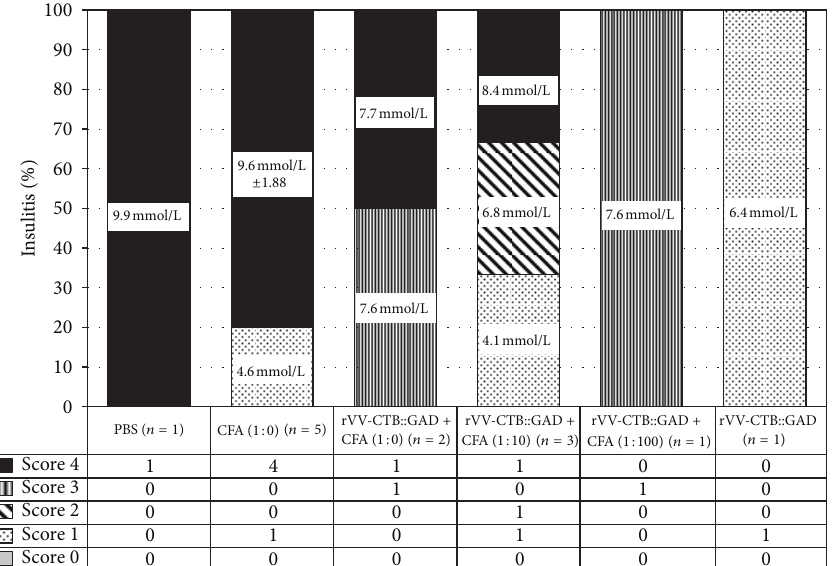
Figure3:Histologicalanalysisofinsulitisinmiceattheendofthehyperglycemiastudy.Dataonpancreatictissuecross-sectionsofeuglycemic mice of different treatment groups obtained from mice at 119 weeks of age are shown. Altogether, 13 mice (presented in the table below the graph) were analyzed and scored for insulitis: one mouse of the PBS control, rVV-CTB::GAD + CFA (1: 100), and rVV-CTB::GAD treatment groups, five mice of the CFA (1:0), three mice of the rVV-CTB::GAD + CFA (1:10), and two mice of the rVV-CTB::GAD + CFA (1:0) groups. Blood glucose concentrations of individual (in mmol/L) or grouped (mean ± SD, in mmol/L) mice are also